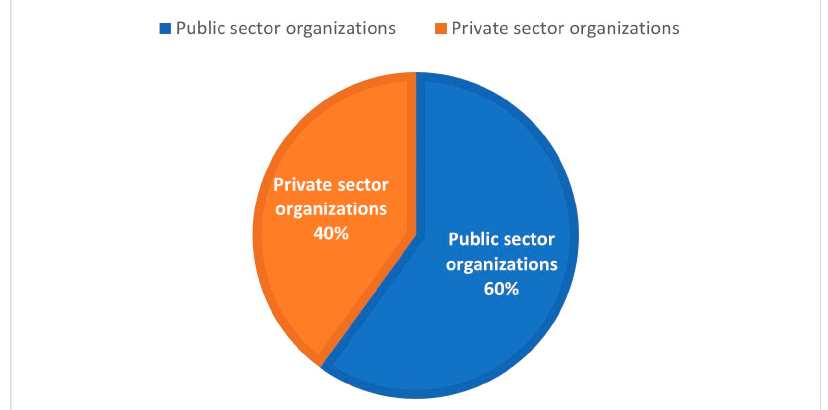
Figure 1. Sector wise segregation of respondents.